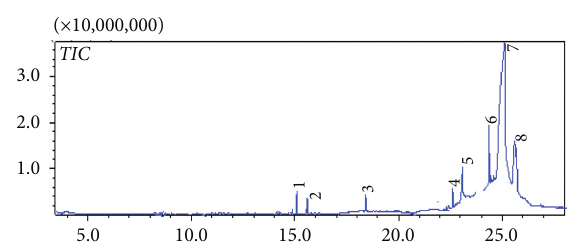
Figure 1: Gas chromatogram of the mother hexane extract FH